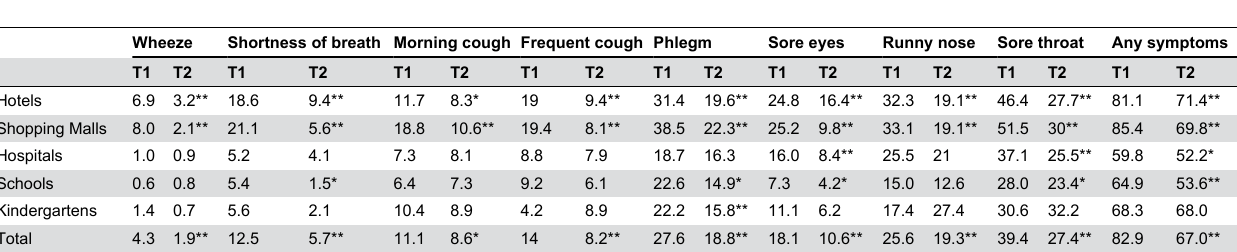
Table 5. Prevalence (%) of respiratory and sensory symptoms among employees before and after legislation.